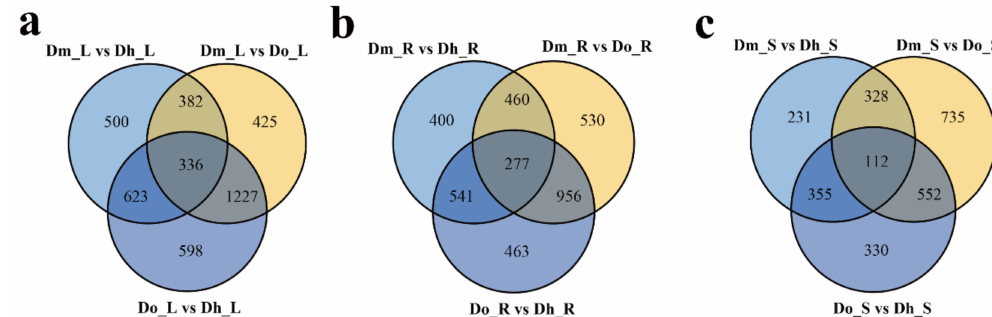
Figure 2. Venn diagram of di ff erentially expressed genes (DEGs) in di ff erent comparisons. All DEGs are grouped into three comparison groups represented by three circles. The overlapping portions of the di ff erent circles represent the number of DEGs common to these comparison groups. ( a ) Venn diagram of three kinds of Dendrobium leaves. ( b ) Venn diagram of three kinds of Dendrobium roots. ( c ) Venn diagram of three kinds of Dendrobium